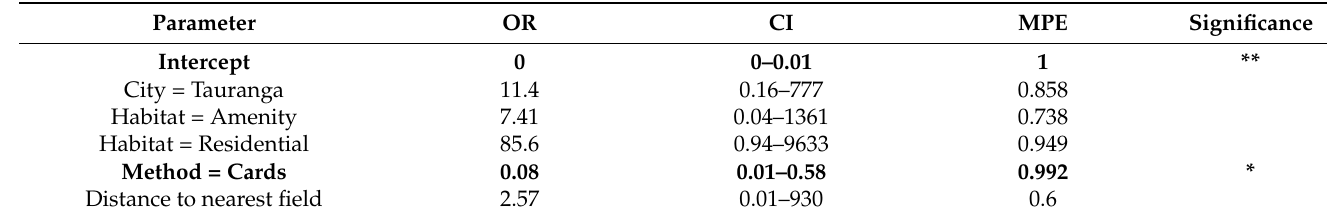
Table 7. Hedgehogs: summary statistics for coefficients of the parameters in the two-city hedgehog model fitted to data from New Plymouth and Tauranga.